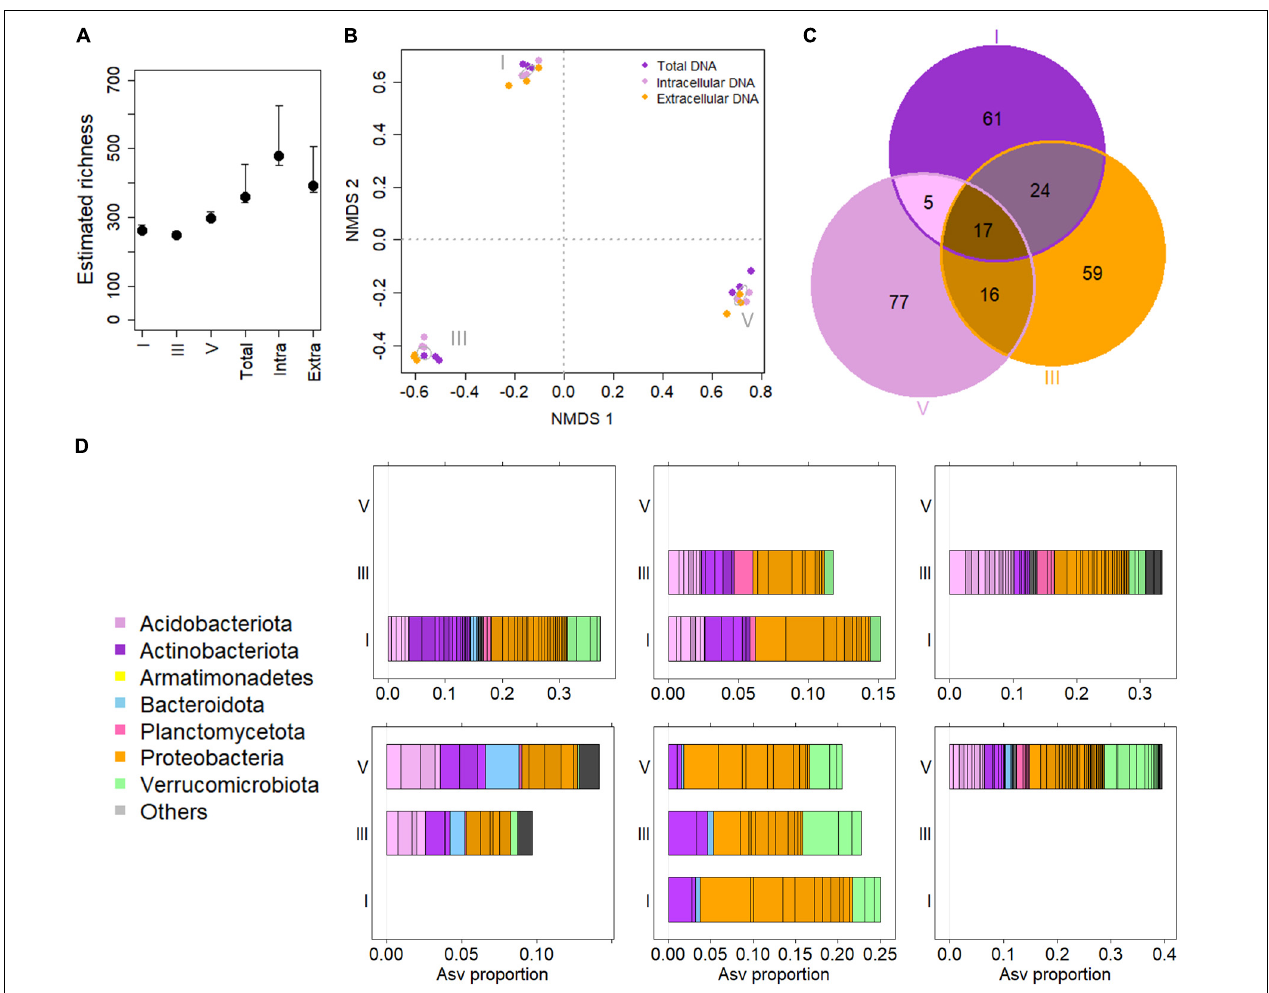
FIGURE 1 | The Picea abies deadwood bacteriome across decay classes (DCls). (A) Estimated ASV richness comparing DCls (I, III, and V) and DNA types (Extra = extracellular DNA fraction, Intra = intracellular DNA fraction, Total = total DNA pool). (B) Non-metric multidimensional scaling of log samples based on Bray Curtis distances. Stress = 0.080. The algorithm converged after 53 iterations. Ellipses were drawn at 95% confidence intervals around group centroids of DCls. (C) Venn diagram illustrating ASV compositions of DCls. (D) Taxonomic overview of Venn sets (C) . The taxonomic composition of ASVs detected only in DCl I is illustrated in the first panel of the top row. The top row second panel shows the composition of ASVs detected in both DCls I and III, but not in DCl V. The top row third panel gives the taxonomic composition of ASVs found only in DCl III. The bottom row illustrates first the taxonomic composition of ASVs detected in both DCls III and V, but not in DCl I. The bottom row middle panel illustrates the taxonomic core microbiome composition of all three DCls. The bottom right panel shows the taxonomic composition of ASVs detected only in DCl V.